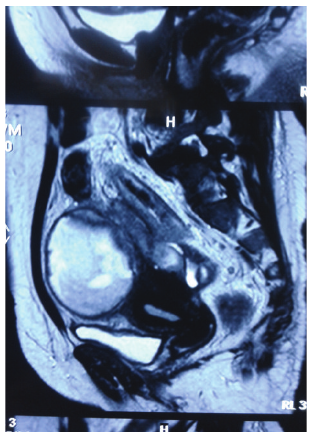
Figure 2: MRI of pelvis showing endometritis of